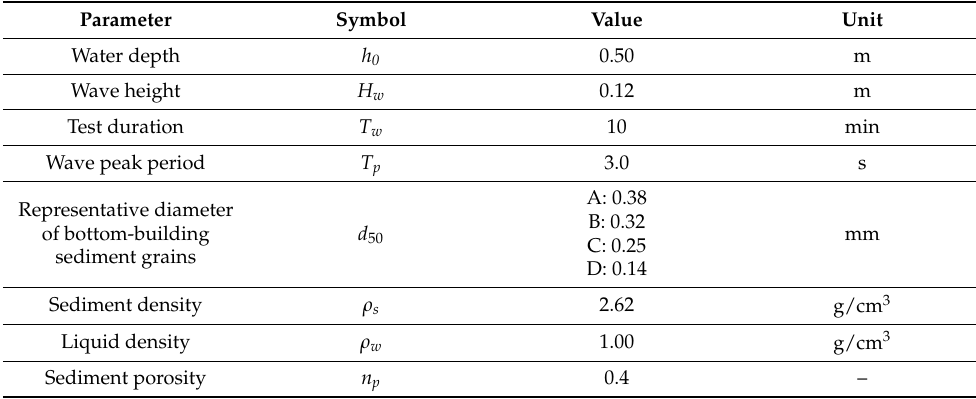
Table 1. Basic data of the flat bottom experiment—IBW PAN